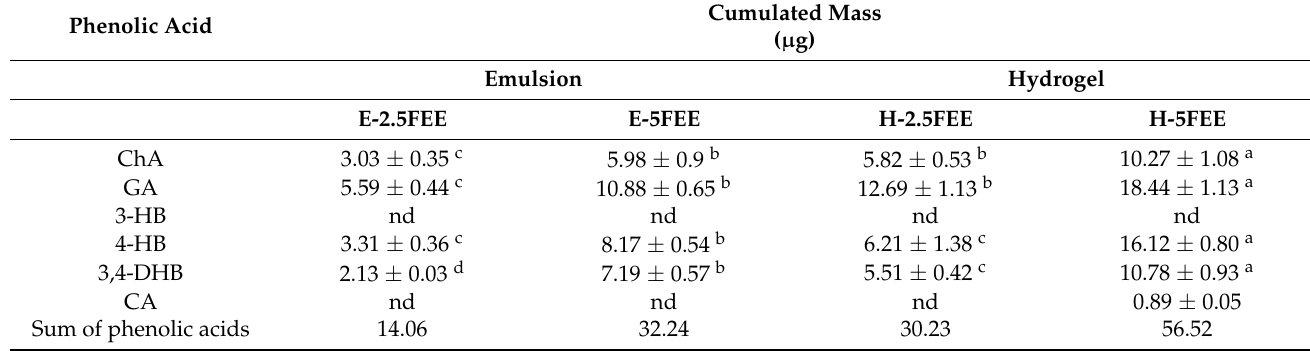
Different letters indicate significant differences between all used vehicles ( α = 0.05).